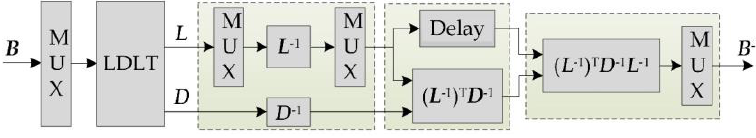
Figure 9. FPGA-based flowchart of B −1 computation.